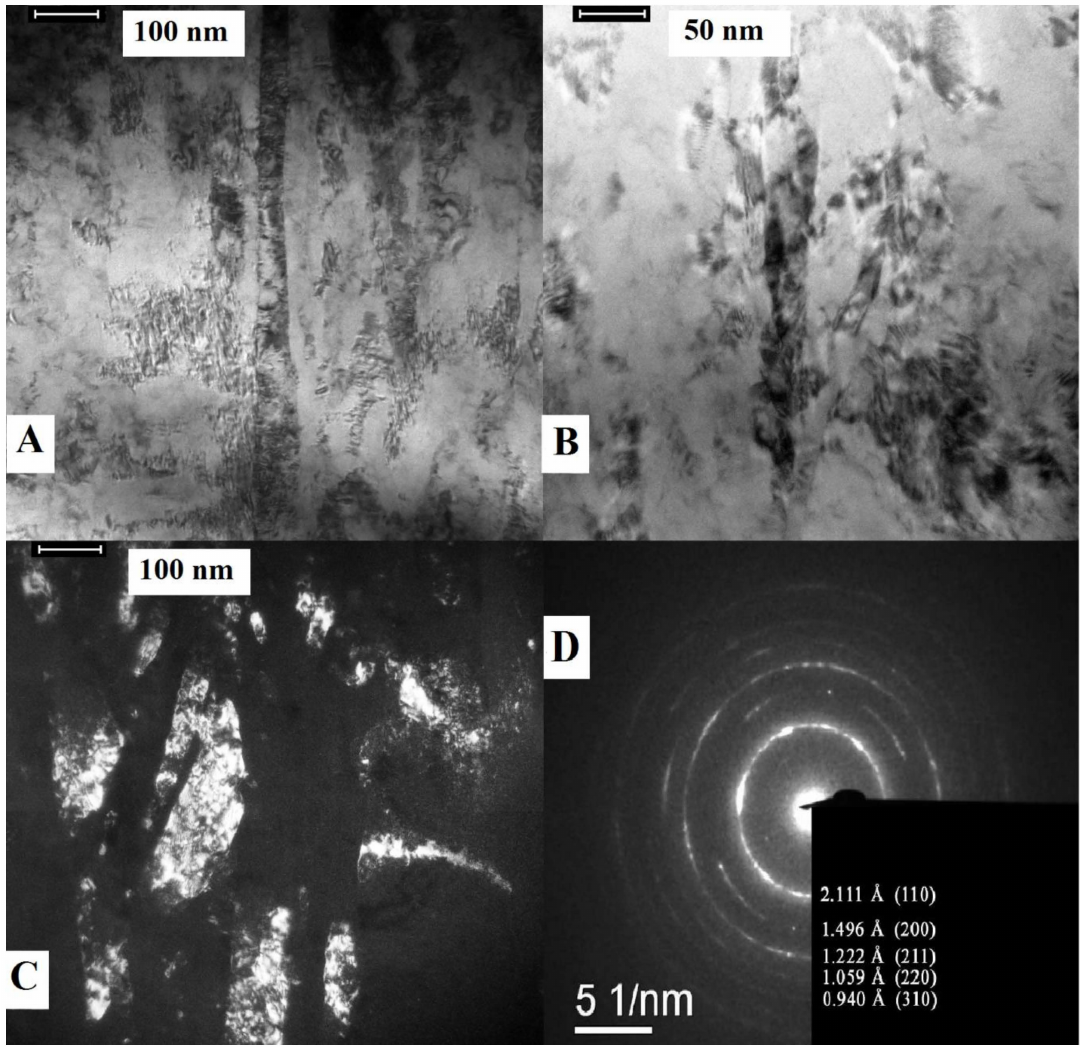
Figure1. ( A,B )Bright-fieldand( C )dark-fieldTEMimagesofthegrainstructureand( D )microdi ff raction pattern of the nitinol wire before treatments. Bright-field images illustrate coaxial elongated grains; dark-field image illustrates more randomly spaced grains and its etched